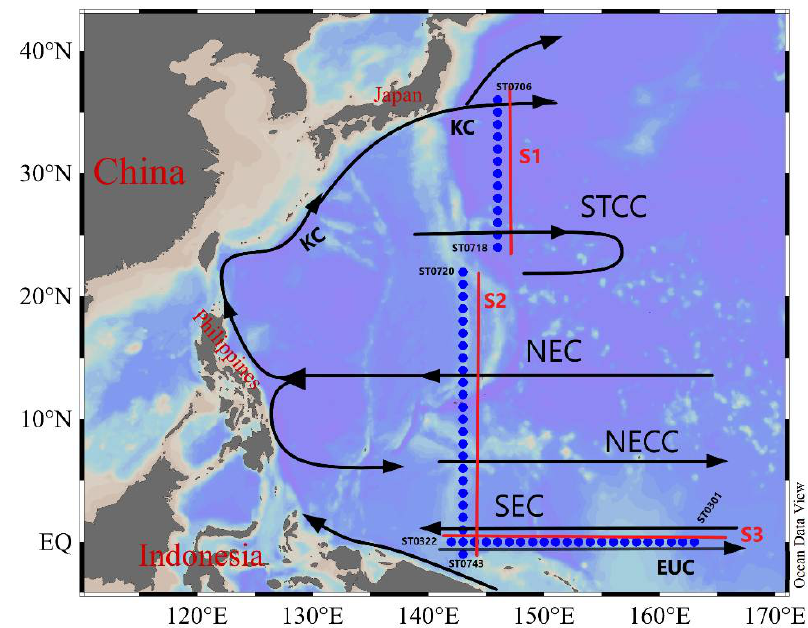
Figure 1. Sampling stations of the 2017 Western Pacific Cruise; the appropriate locations of the different currents are described according to Hu et al. and categorized into S1, S2, and S3 transects based on the shadow environment of the station circulation. Surface currents include the Kuroshio Current (KC), Subtropical Countercurrent (STCC), Northern Equatorial Current (NEC), North Equatorial Countercurrent (NECC), and Equatorial Undercurrent (EUC).